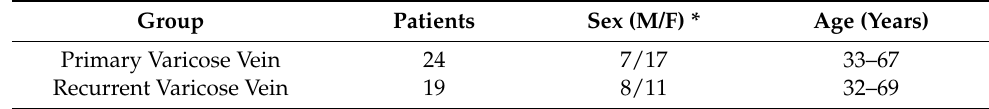
Table 1. Basic characteristics of groups.